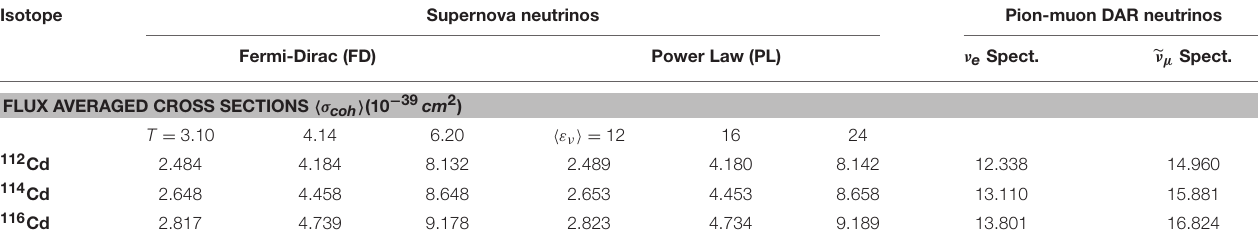
σ coh , as in Table 3 but now referred to: (i) three different Supernova neutrino spectra determined from the parameters TABLE 4 | Flux averaged coherent cross sections i h of: (a) Fermi Dirac parametrizations and (b) Power-Law parametrizations, and (ii) the energy spectra of Pion/muon decay at rest (DAR) neutrinos. Isotope Supernova neutrinos Pion-muon DAR neutrinos Fermi-Dirac (FD) Power Law (PL) ν e Spect. ν µ